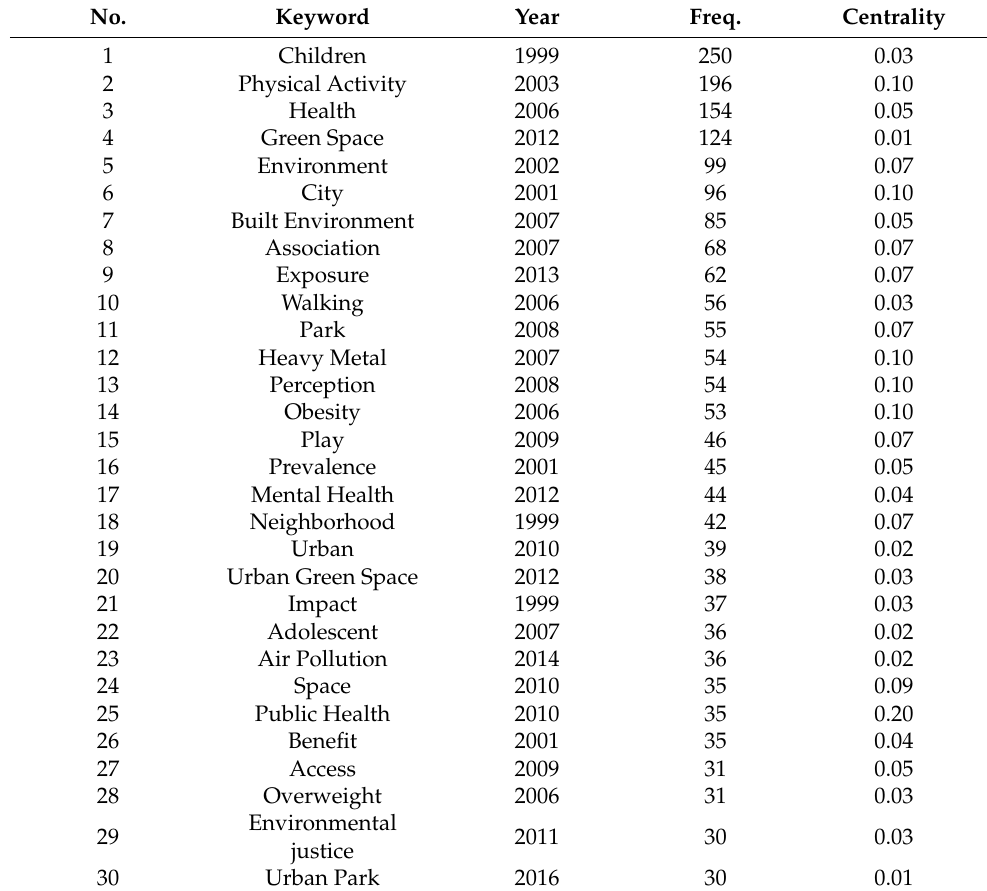
Table 3. Top 30 most frequently used keywords during 1980–2022.